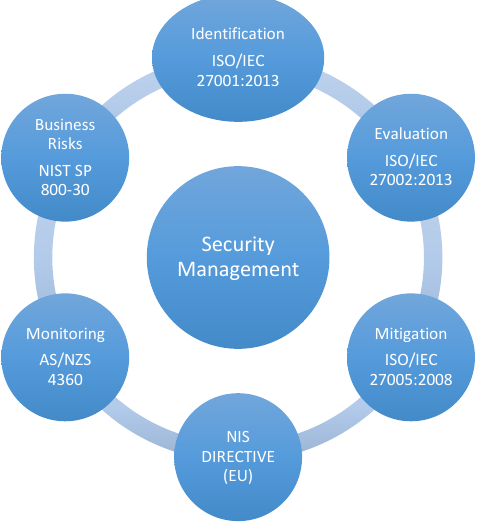
Figure 4: Security Management